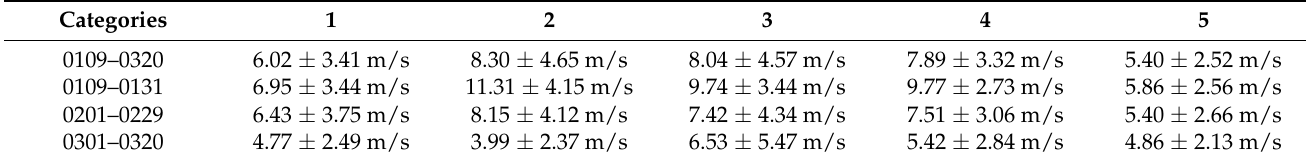
Table 7. The average horizontal wind speed at 10 m above the ground at different atmospheric stabilities at site 2.